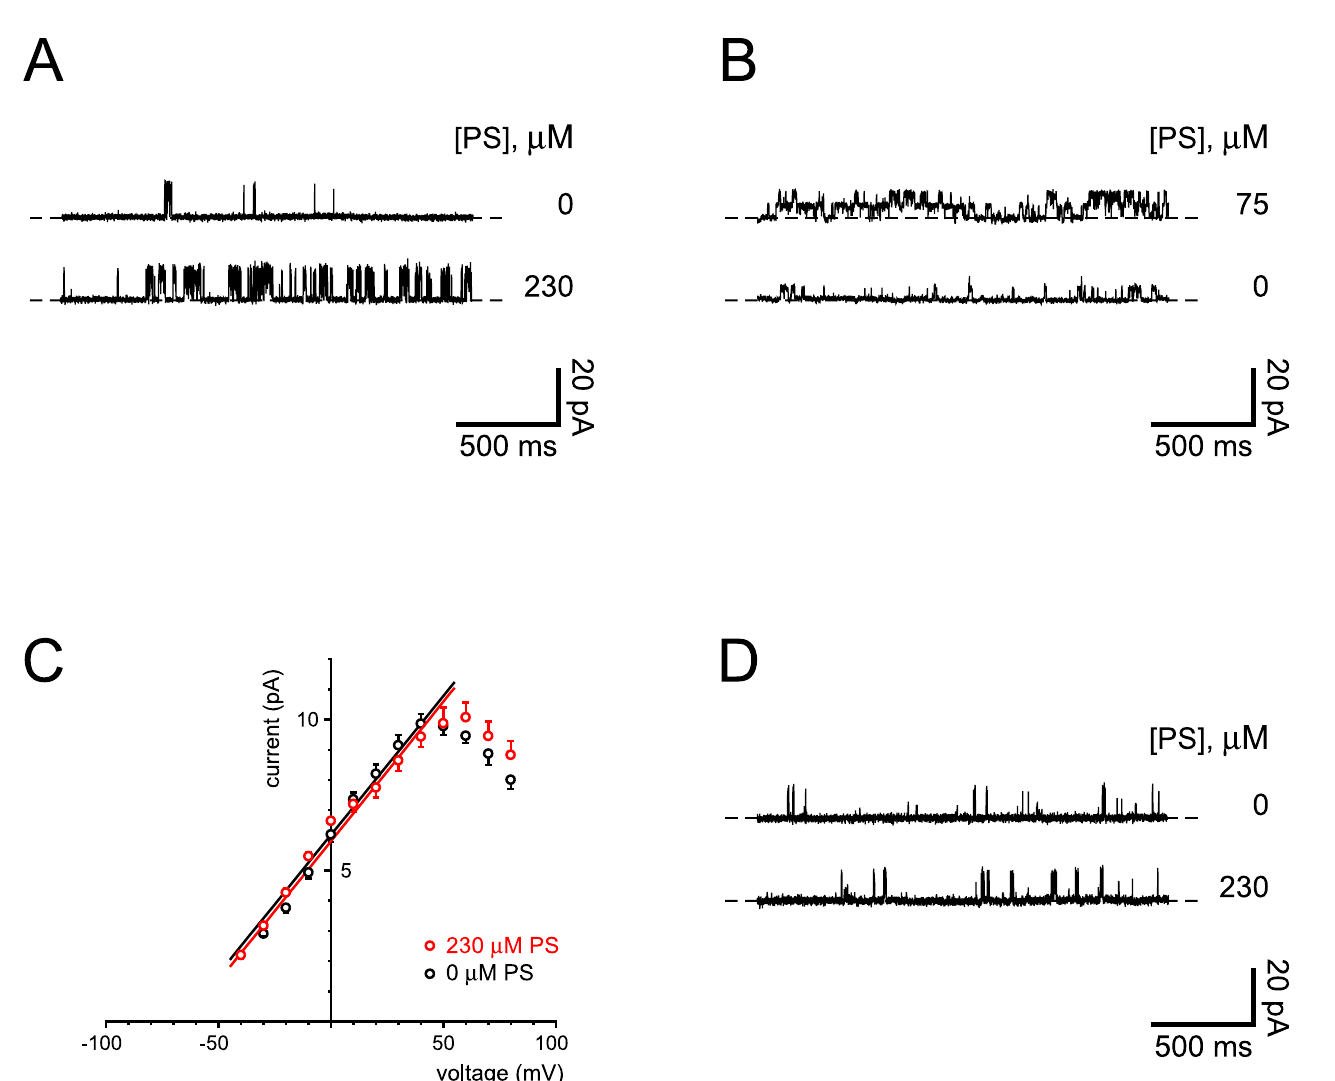
Fig 1. Activation of ciliary channels by pregnenolone sulfate. (A) The top recording shows the activity of a single ciliary channel observed while recording in the standard solutions (with 0.1 μ M cytoplasmic free Ca 2+ ). The bottom recording shows increased channel activity in the same cilium 5 min after perfusion of the pipette with standard external solution to which 230 μ M pregnenolone sulfate had been added. The holding potential was +60 mV for both recordings. The dashed lines indicate the current level when the channel was closed. (B) The top recording shows the activity of two ciliary channels observed with the standard pipette (external) solution to which 75 μ M pregnenolone sulfate had been added. The bottom recording shows decreased channel activity in the same cilium 4 min after perfusion of the pipette with the standard external solution, which lacks pregnenolone sulfate. For both recordings, free Ca 2+ was 3 μ M and the holding potential was − 10 mV. (C) Single-channel current-voltage relation measured in standard external solution without (black) or with (red) 230 μ M pregnenolone sulfate. For all recordings, cytoplasmic free Ca 2+ was either 0.1 or 3 μ M. Each point shown is the mean of measurements in 3 to 5 cilia (without pregnenolone sulfate) or 7 to 10 cilia (with pregnenolone sulfate). Each straight line is fit to the linear portion of its relation ( − 40 to +50 mV; R 2 0.972, P < 0.001 without pregnenolone sulfate; R 2 0.992, P < 0.001 with pregnenolone sulfate). (D) The top recording shows the activity of a single ciliary channel observed while recording in the standard solutions. The bottom recording shows channel activity in the same cilium 5 min after replacing the cytoplasmic solution with one containing 230 μ M pregnenolone sulfate. Both cytoplasmic solutions contained 0.1 μ M free Ca 2+ . The holding potential was +60 mV for both recordings.